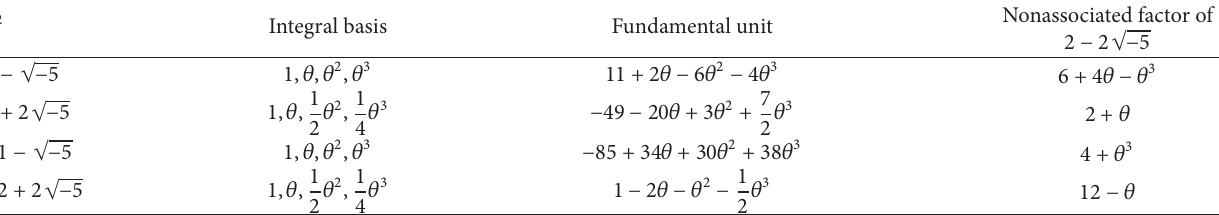
Table 1: Associated number field.